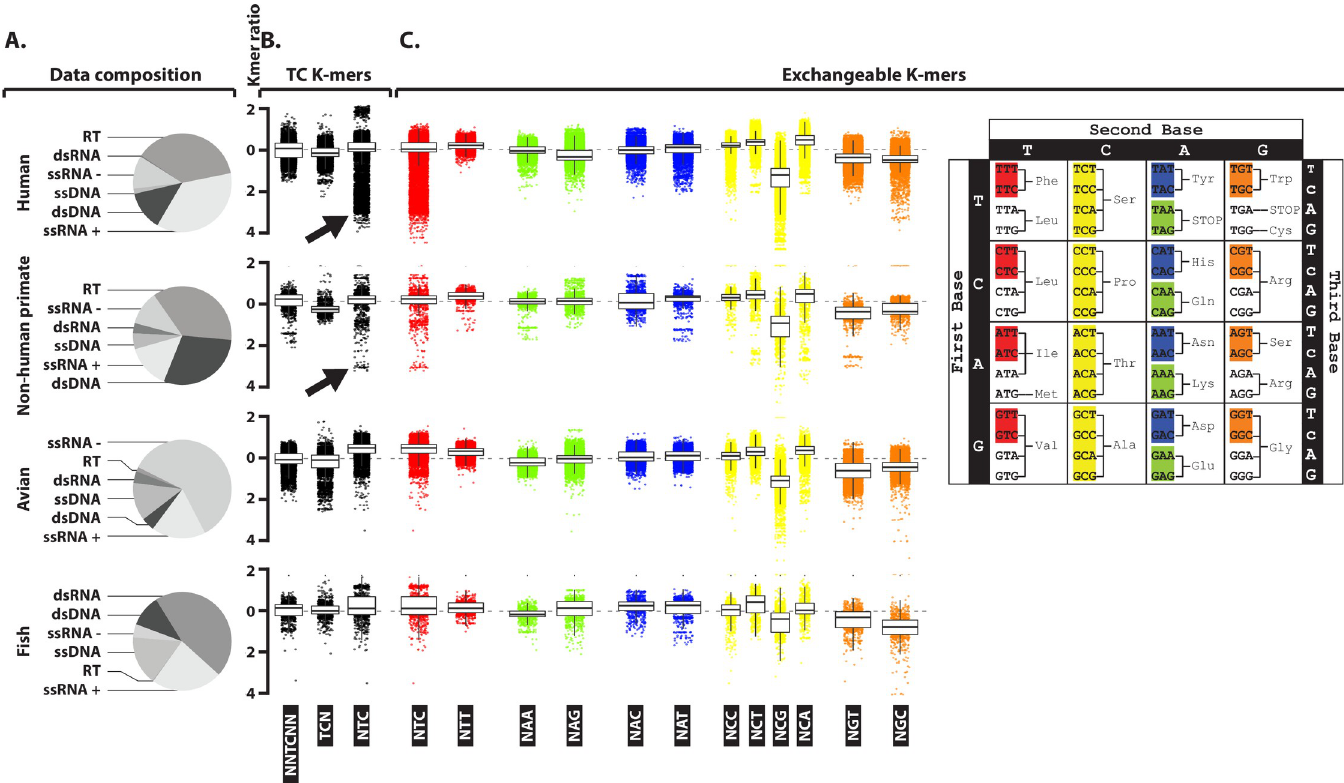
Fig 3. A sub-population of Human and non-human primate viruses is depleted in NTC codon. Four datasets including Human viruses (n = 33,400), non-human primate viruses (n = 1,397), avian viruses (n = 9,160) and fish viruses (n = 570) have been analyzed for their observed/expected K-mer ratios. A. The composition of each data set regarding the breakdown into viral groups is illustrated by pie charts. B. The observed/expected ratios of TC dinucleotide at various codon positions for Human, non-human primate, bird and fish viruses are illustrated by dot plots (one point represents one unique viral sequence). C. K-mers are grouped and colored according to their capacity to encode a common amino-acid (in red for NTT/C, in yellow for NCC/G/T/A, in orange for NGT/C, in blue for NAC/T and in green for